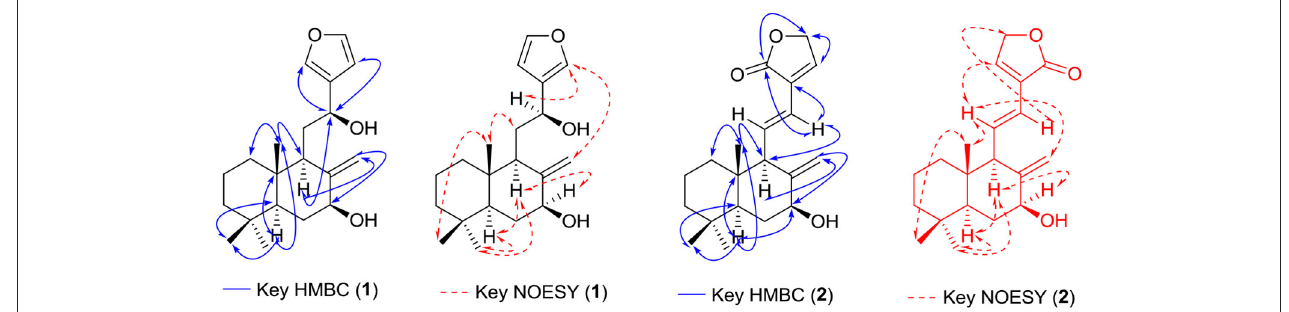
FIGURE 2 | Key HMBC and NOESY correlations of compounds 1 and 2 .